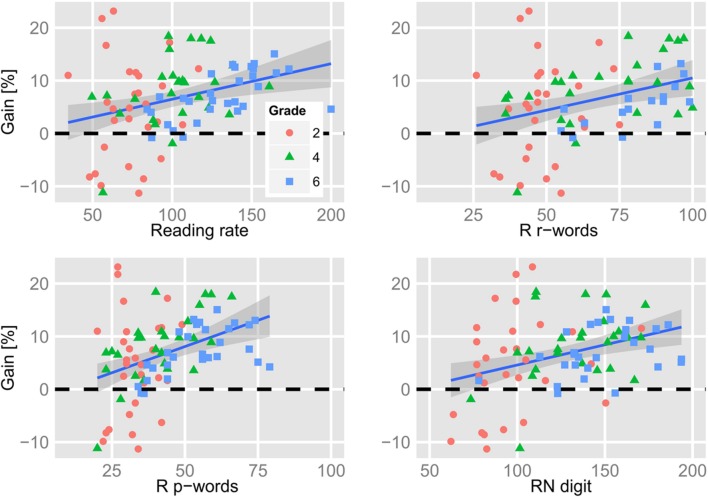
Relation between the percentage of gain (preview benefit) with psychometric measures (reading rate from the eye tracking task, reading real words, reading pseudowords, and rapid naming digits). Positive values (i.e., values above the bold dashed line) indicate gain that is the proportional reduction of the first fixation duration in relation to the salience of the parafoveal preview of the target words (see Figure 5 and main text for details).